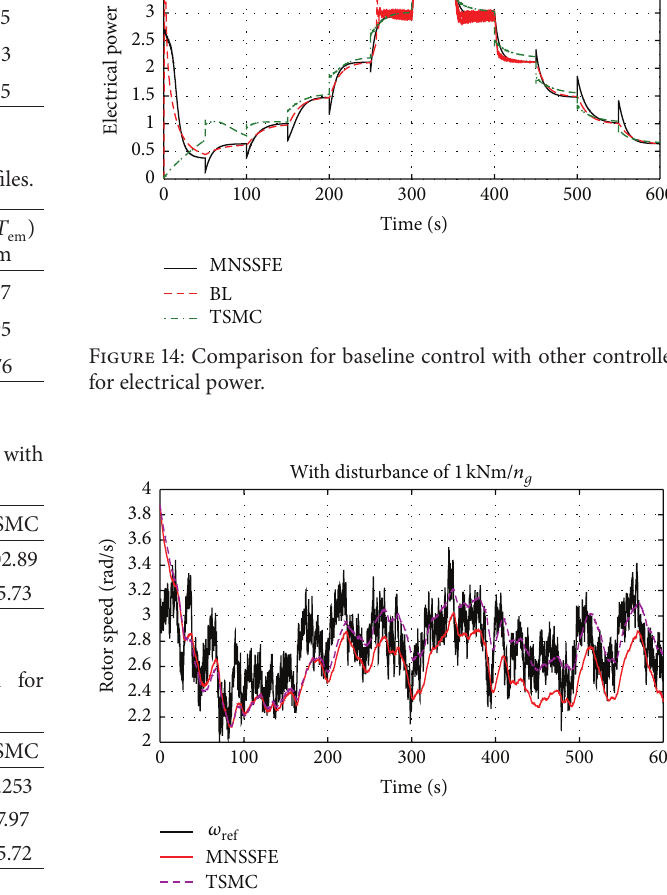
Figure 15: Rotor speed comparison for MNSSFE and TSMC with constant additive disturbance of 1kNm/ 𝑛 𝑔